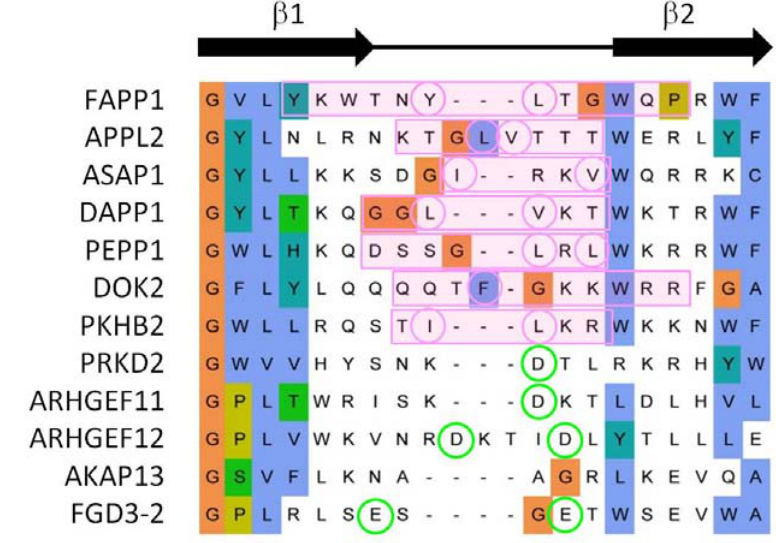
Figure 5. Sequence alignment of representative β 1- β 2 loop of PH domains. The MODA patch is indicated with a pink box and the hydrophobic amino acids circled in pink. When no MODA patch was found, the acidic residues are circled in green. The sequence alignment is extracted from that of the entire family as described in the Experimental